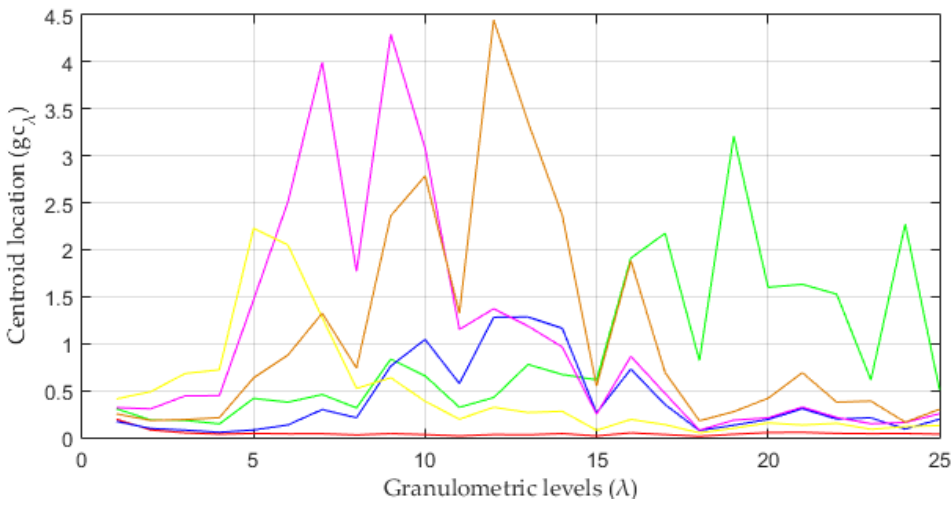
Figure 17. Granulometric profiles of 6 classes from 12 granulometric levels. Kirib Kaina, 1975.